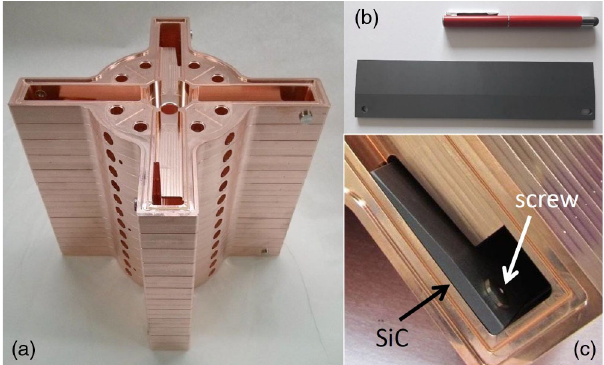
FIG. 5. Brazed 12-cell module (a); SiC absorber (b); detail of the SiC absorber fixed inside the module (c).